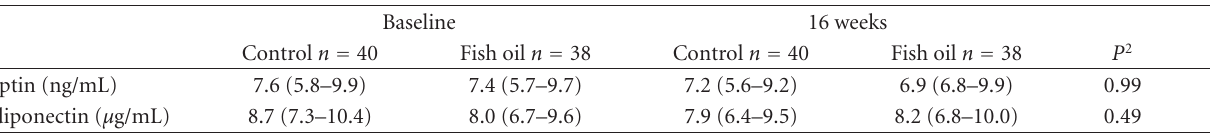
Table 3: Plasma concentrations of adipokines 1